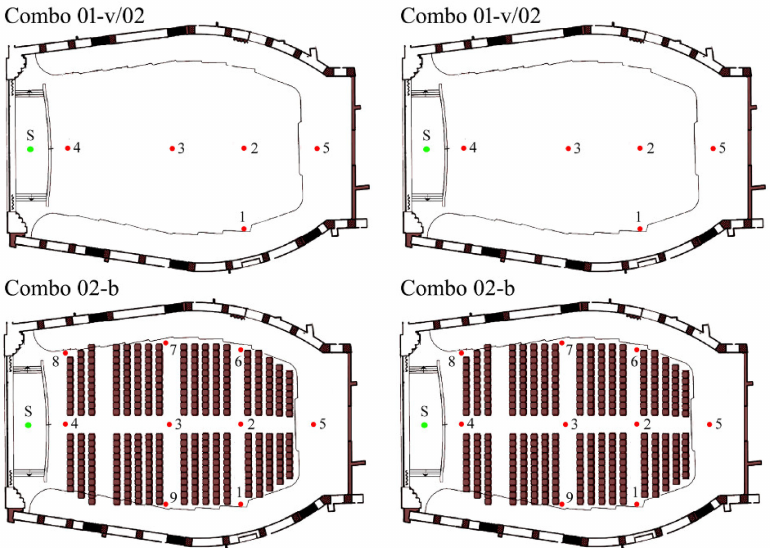
Figure 9. Positioning for the acoustic surveys for Combo 01-v/02 and Combo